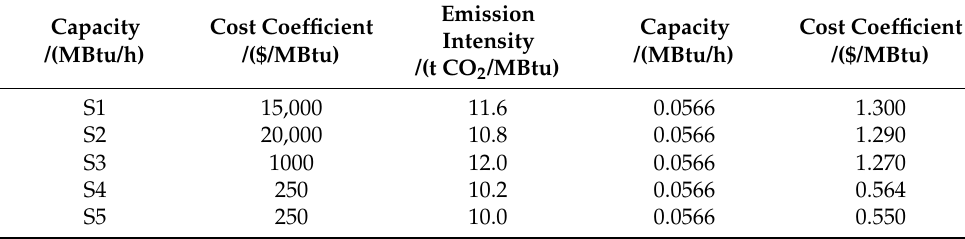
Figure 5. The modified IEEE 39-bus power system and the Belgian 20-node gas system. Table 1. Parameters o f the thermal power units.